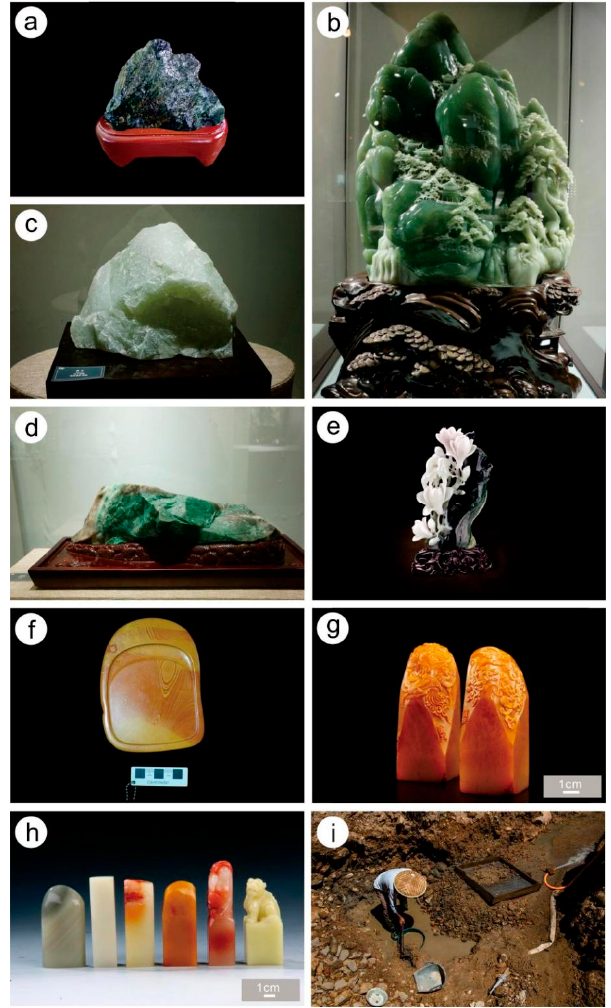
Figure 7. Representative jade carving photographs and mineral processing scene. ( a ) The serpentine jade carving from Shandong province. ( b ) The serpentine jade carving from Liaoning province. ( c ) The Xiuyan serpentine jade has unevenly distributed silk floss and opaque white cloud-shaped inclusions. ( d ) Dushan jade from Henan province. ( e ) The Dushan jade carving measures 19 cm high. ( f ) The Hongsi inkstone with the filiform pattern. ( g ) Seal stone used by ancient royalty was engraved with dragon and phoenix patterns. ( h ) Different colors of the Chinese seal stone. ( i ) Tianhuang stone (a kind of Chinese seal stone) processing scene. (Figure 7b–d are collected in the Geological Museum of China, and Figure 7e is provided by Beijing Boguan International Auctioneering Co., Ltd. (Beijing, China), and Figure 7g is available from www.christies.com (accessed on 9 May 2016), and Figure